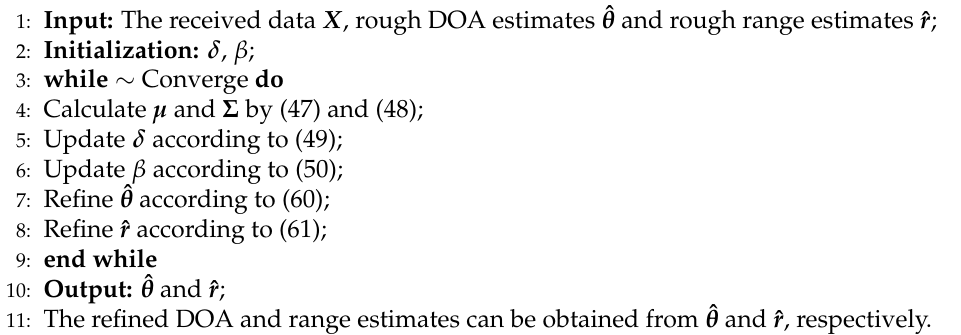
Algorithm 3 Refined DOA and Range